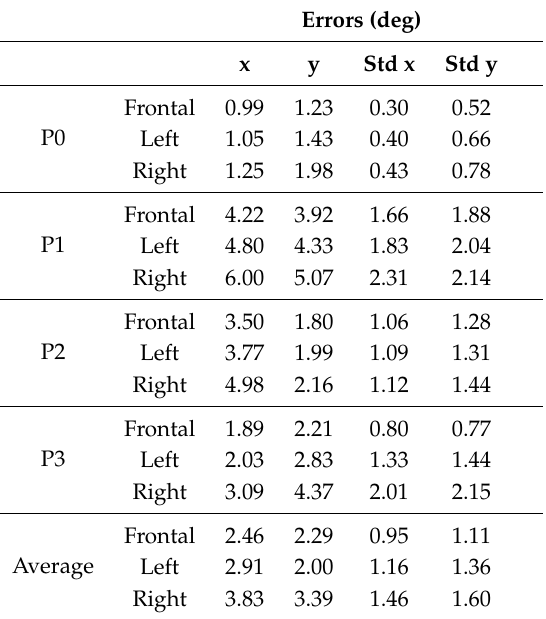
Table 1. Experienced gaze estimation errors under varying lighting conditions (light source described in the second column) with 4 typically-developed adults. The headers of the columns Std x and Std y stand for standard deviation along x and y axes